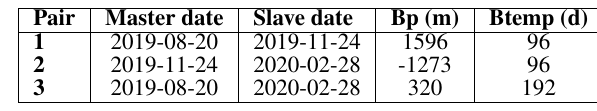
Table 2. Interferograms formed with the available images. Bp stands for perpendicular baseline, and Btemp stands for temporal